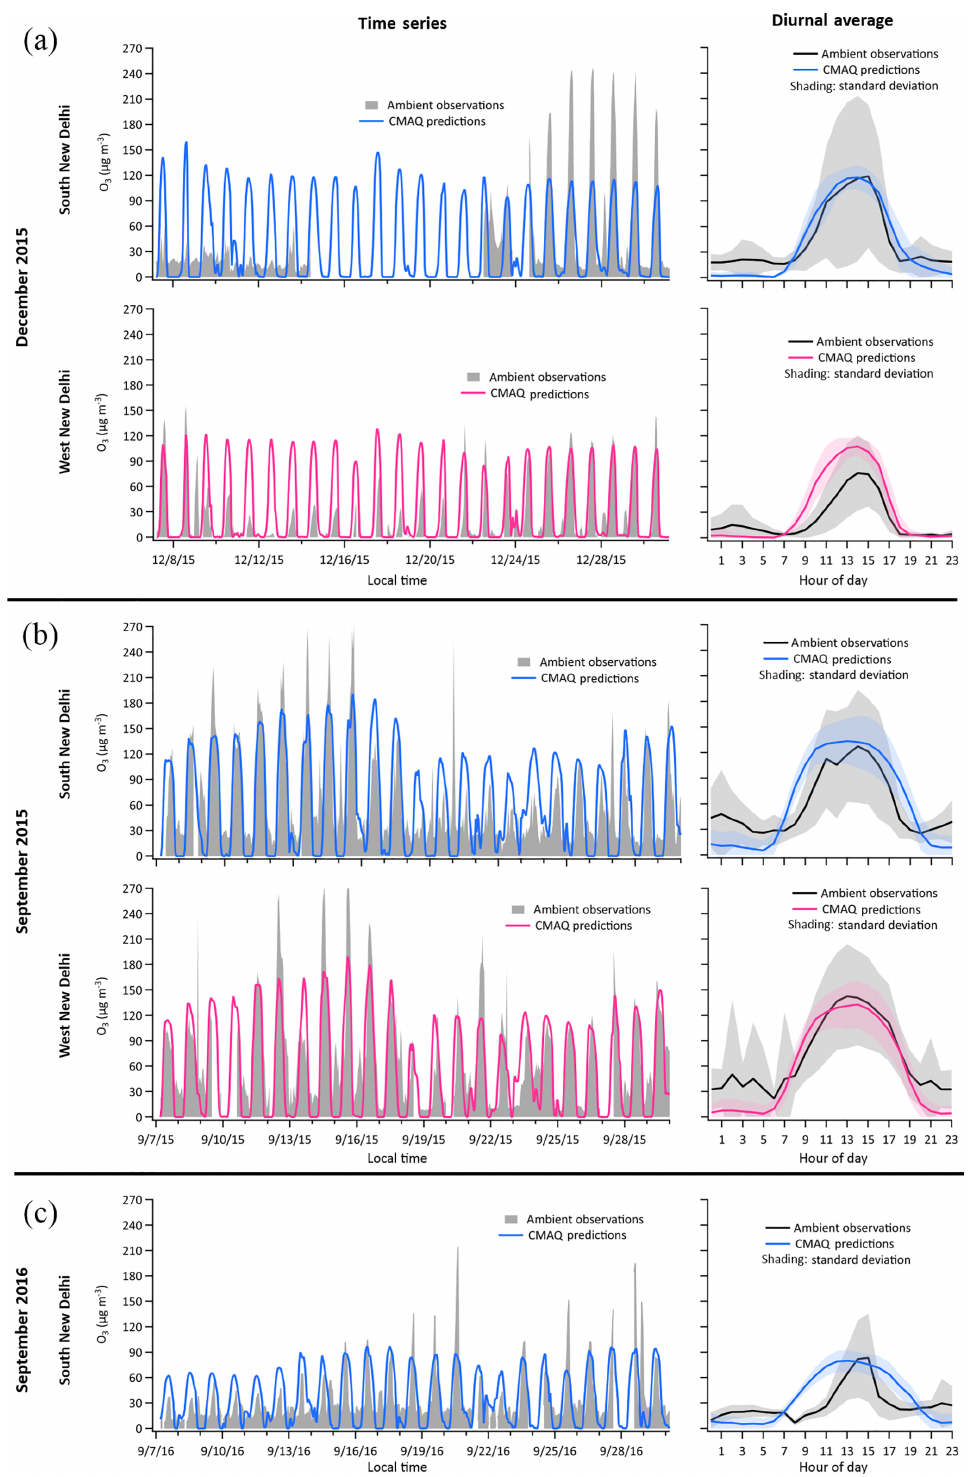
Figure 13. Predicted O 3 (left) and average diurnal cycle (right) for 20–31 December 2015 (a) , 7–30 September 2015 (b) , and 20–30 Septem- ber 2016 (c) in West New Delhi (pink), and South New Delhi (blue). Standard deviations of the diurnal profiles for observations and predictions are indicated, respectively, by colored shading. Diurnal profiles were averaged over simulation durations (Table 7). Computations were carried out at 4km